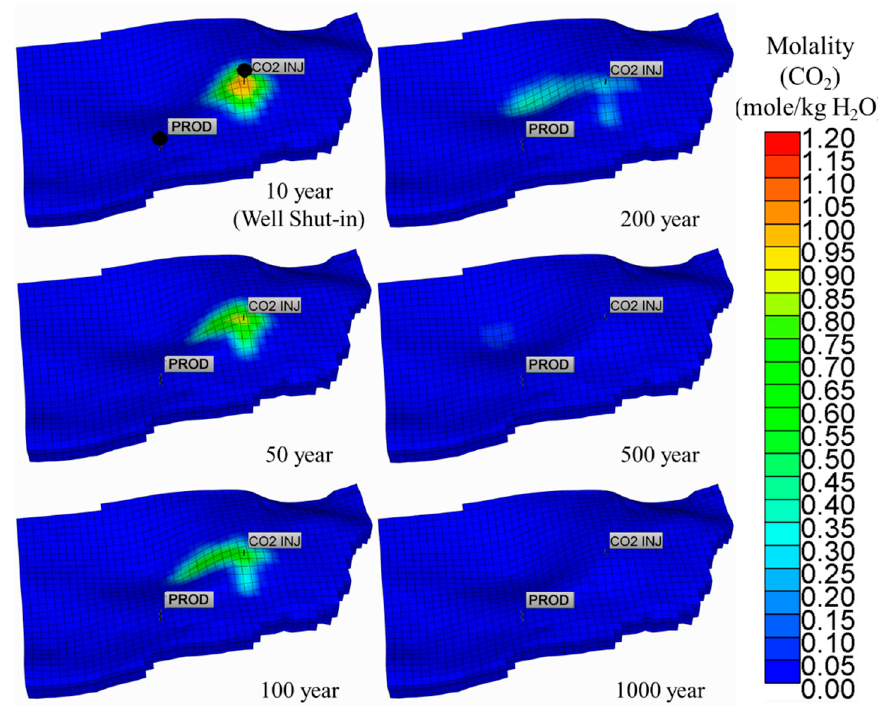
Figure 11. Spatial distribution of the CO 2 molality in the dissolved CO 2 scenario.